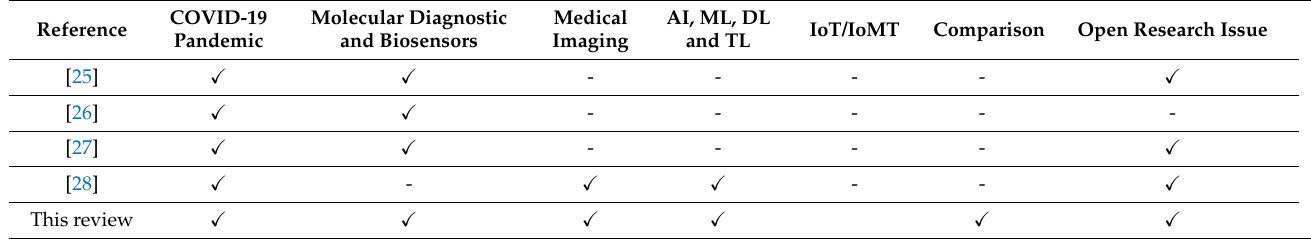
Table 1. Comparison with similar